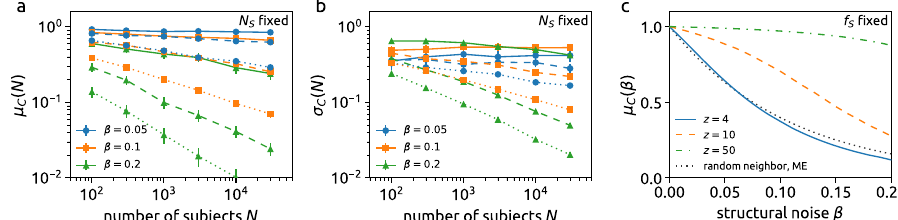
Fig. 5 Scaling of opinion consistency achieved by the majority rule in synthetic worlds. a , b The dependencies of μ C and σ C on the number of subjects, N , are affected by both structural noise, β , and mean degree, z (the solid, dashed, and dotted lines are used for z equal 50, 10, and 4, respectively). One seed opinion is used ( N S = 1). The symbols and error bars show the mean and three times the standard error of the mean, respectively, obtained by running the model on 1000 realizations of regular random networks. c The dependence of mean opinion consistency, μ C , on structural noise, β , for a fi xed fraction of seed opinions, f S = 0.01, N = 10,000, and N S = f S N . The results are averaged over model realizations on 1000 regular random networks, the error bars are too small to be shown. The dotted line shows the analytical result μ C ¼ f 2 β S for the random neighbor rule when the same fi xed fraction of seed opinions, f = 0.01, is S